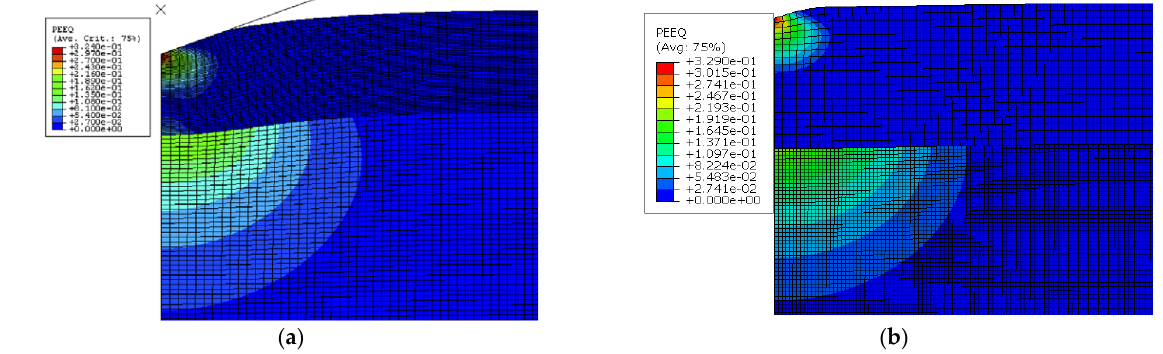
Figure 7. PEEQ comparison in the hard film/soft substrate model at h max = 900 nm: ( a ) reported result